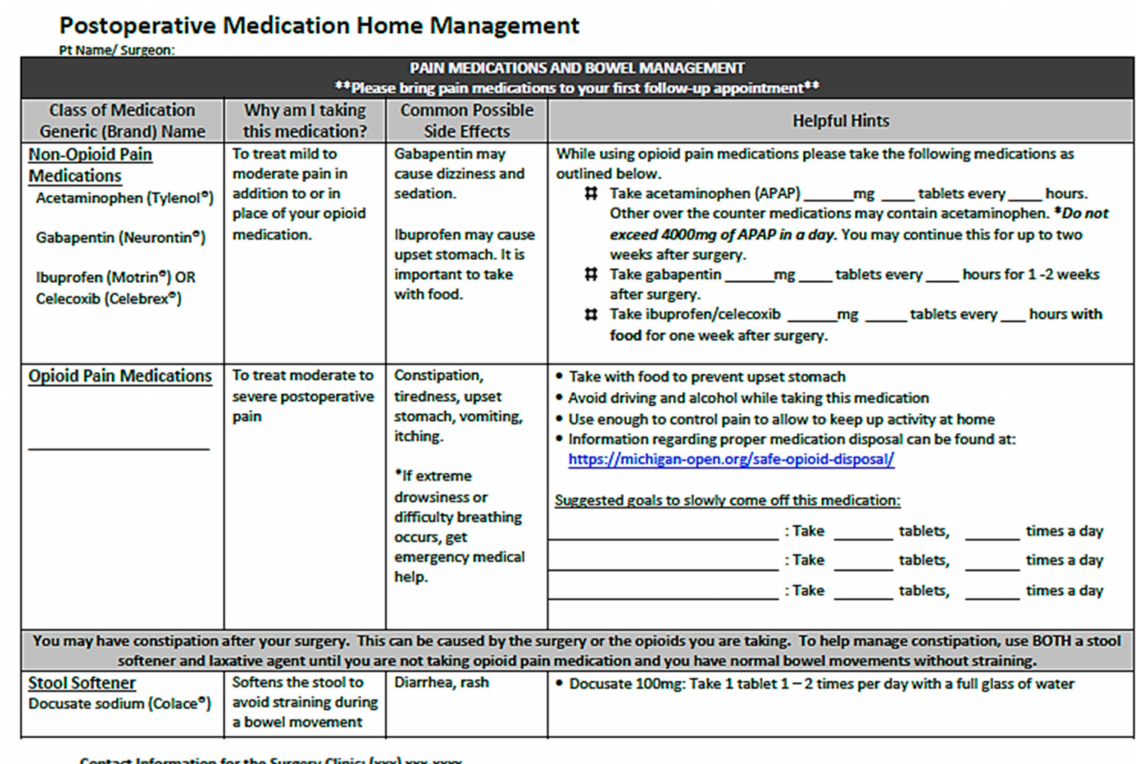
Figure 2. Example of a Pain Management Exit Plan (PMEP) to be used at postoperative hospital